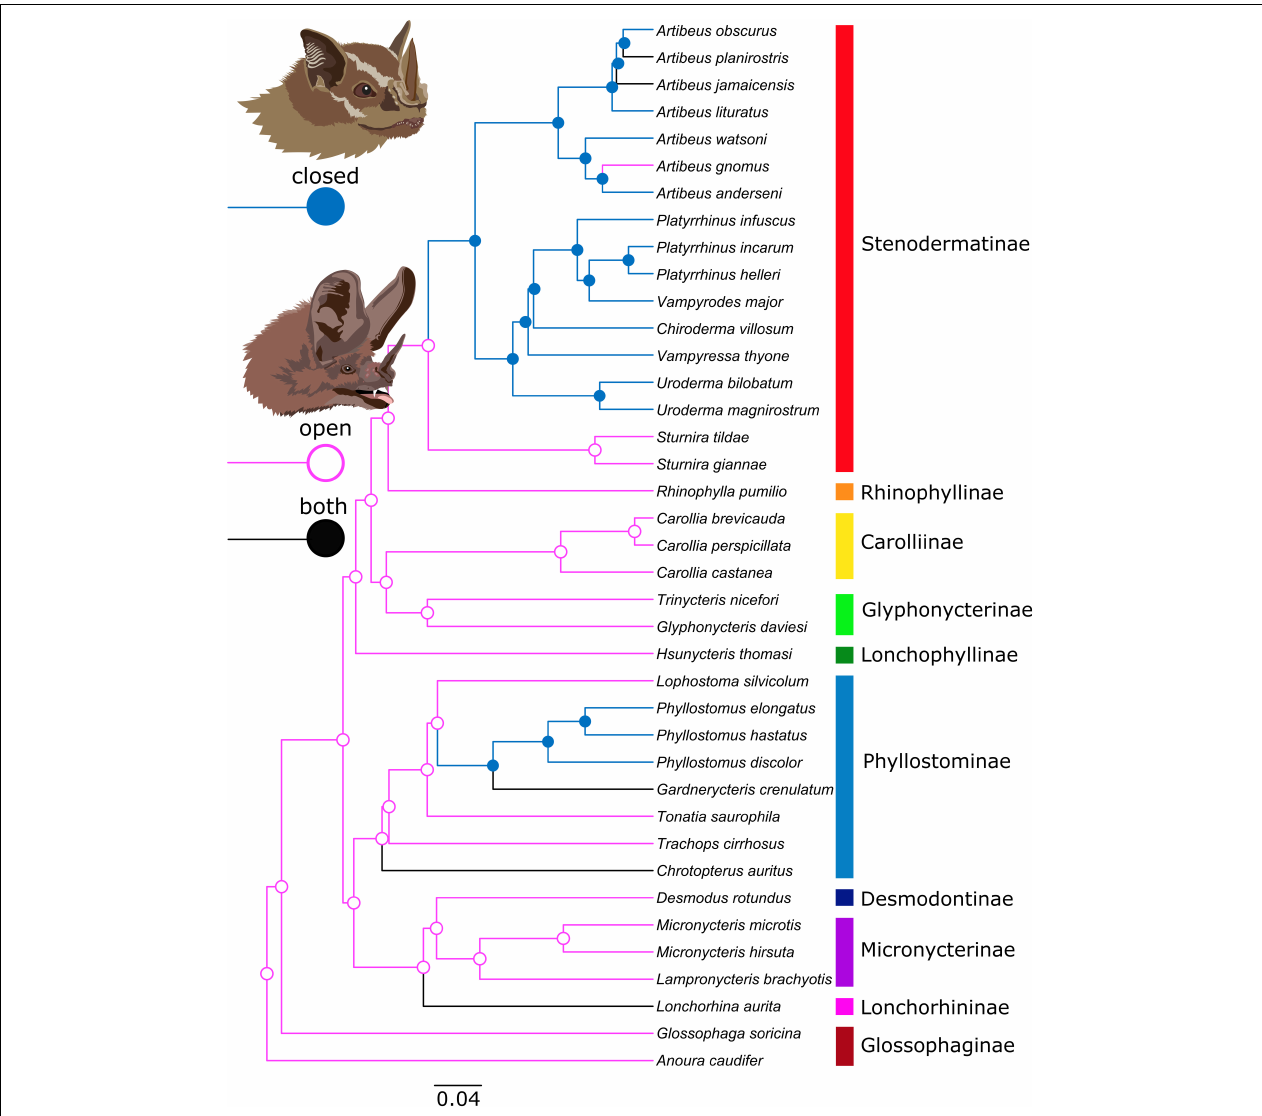
FIGURE 3 | Ancestral state reconstruction of mouth posture. The MCC tree was constructed with TreeAnnotator v.1.10.4 on Beast v1.10.4 runs using sequence data provided in Rojas et al. (2016) (see Supplementary Table 3 ). Mouth posture was reconstructed as a discrete trait with an asymmetric substitution rate. Colors and node shapes indicate the mouth posture state (pink/light circle = open-mouth species; blue/filled circle = closed-mouth species; black = “both”). Posterior support is shown on the tree. Subfamilies are indicated by rainbow colors (Illustrations by D.